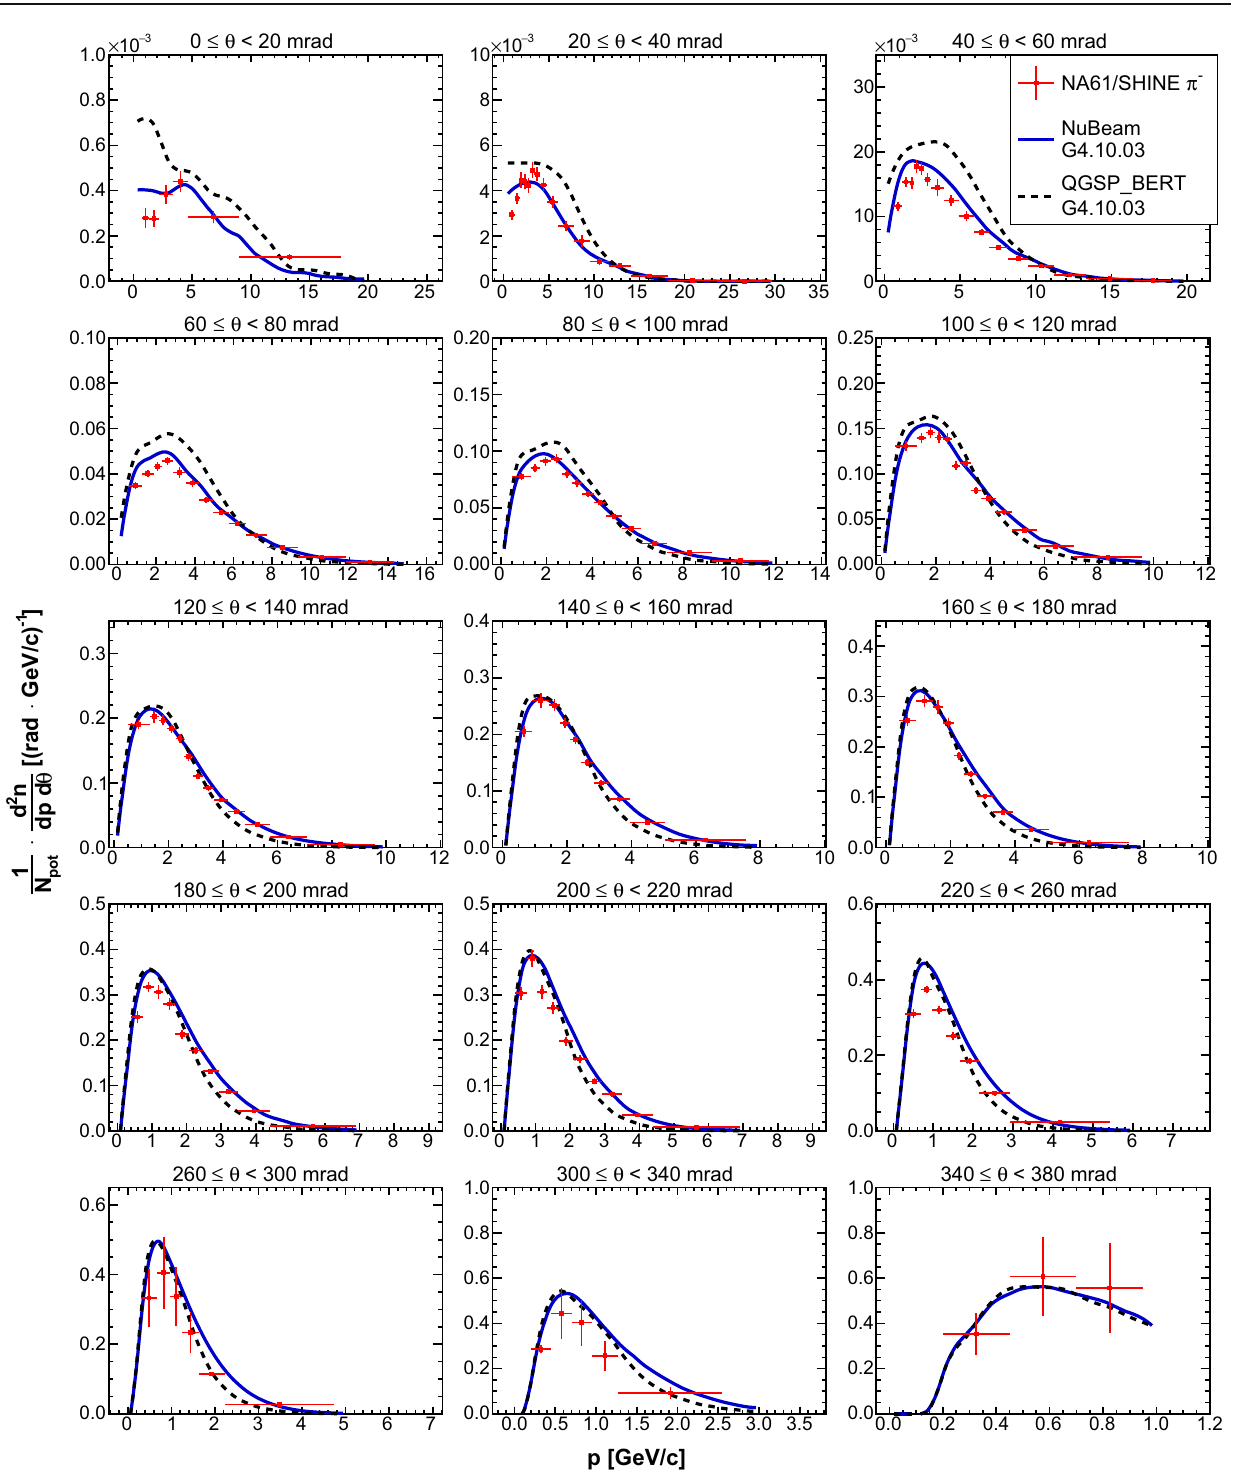
Fig. 29 Double differential yields of negatively charged pions for the mostupstreamlongitudinalbin(0 ≤ z < 18cm).Verticalbarsrepresent the total uncertanties. Predictions from the NuBeam (solid blue line)